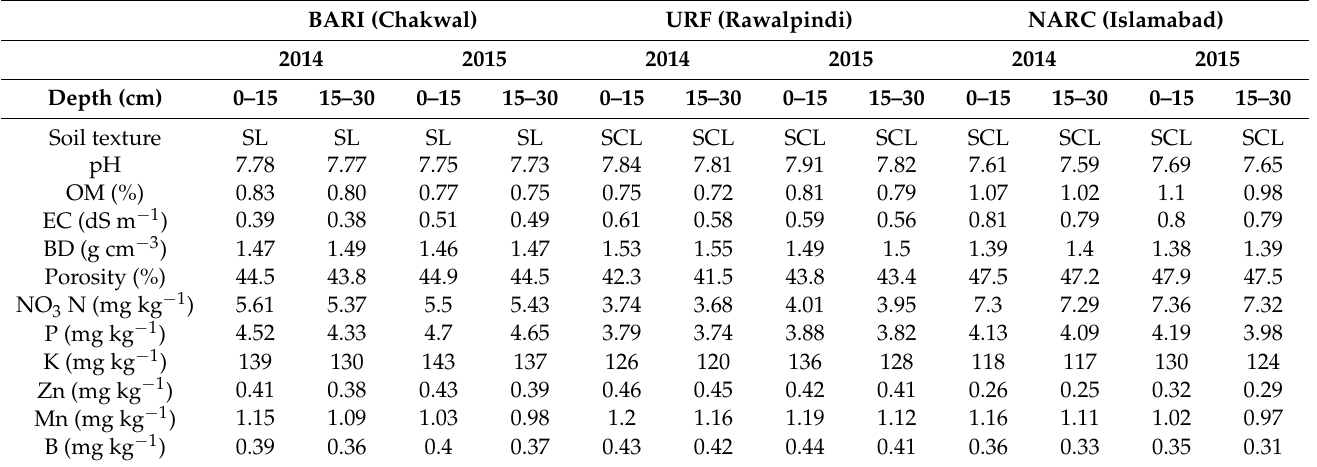
Table 1. Soil physio-chemical analysis of the experimental sites during 2014 and 2015.